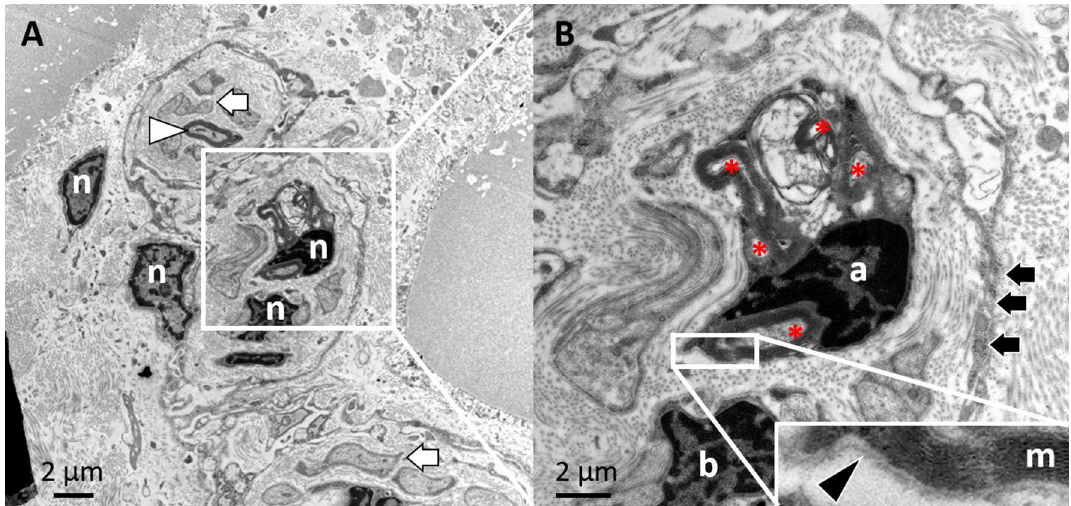
Figure 12. Ultrastructure image by TEM of a nerve within the medulla of an inguinal lymph node. ( A ) In addition to myelinated (white arrowhead) and non-myelinating Schwann cells (white arrow), a curios structure is found in the centrally part of the bundle. ( B ) Surrounded by the endoneurium (black arrow), there are two nerve-accompanying cells (a and b) that obviously myelinate (m) more than one axon (asterix). This structure is completely surrounded by a basement membrane (black